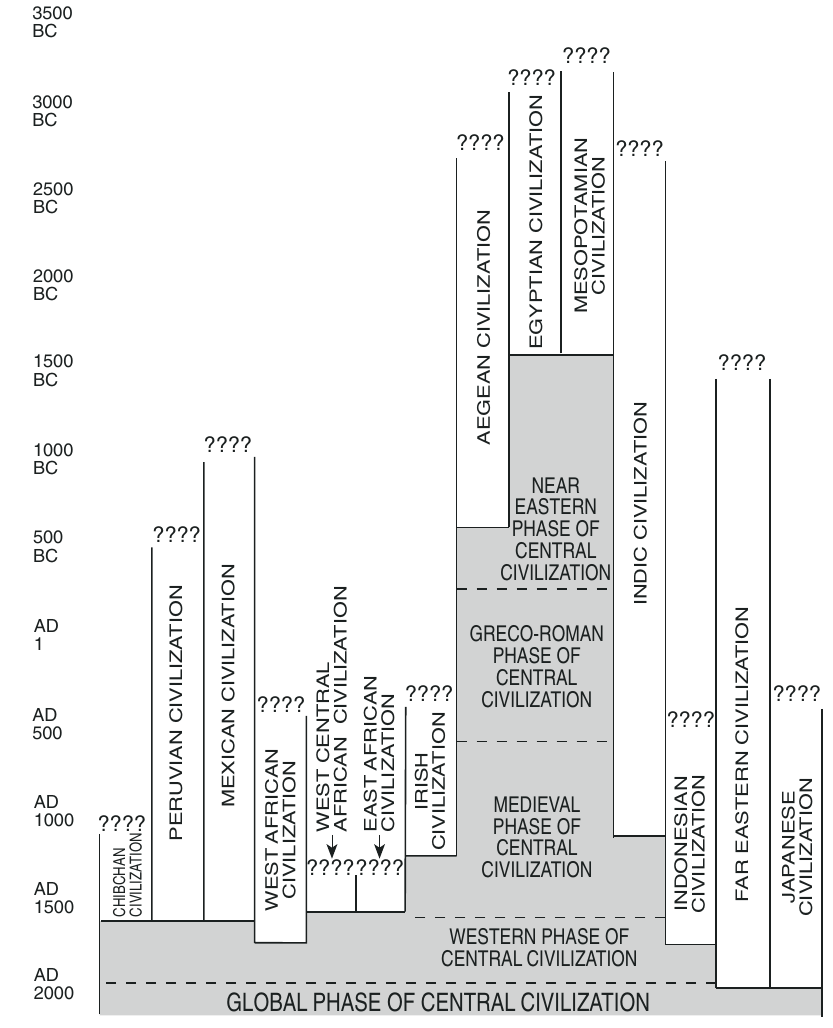
took place no later than this data for this case.